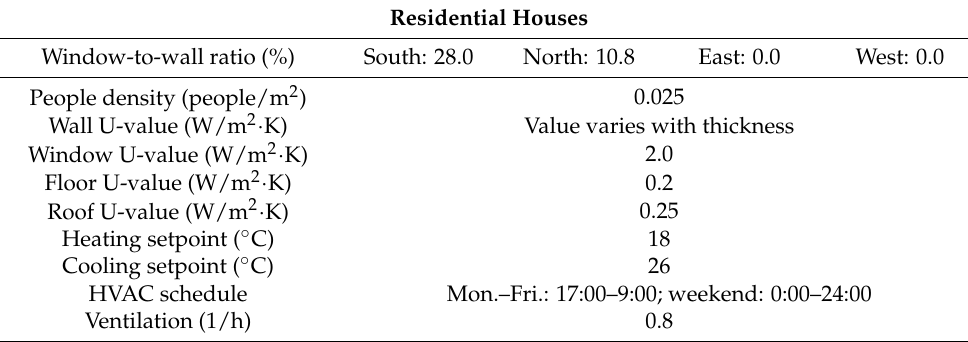
Residential Houses